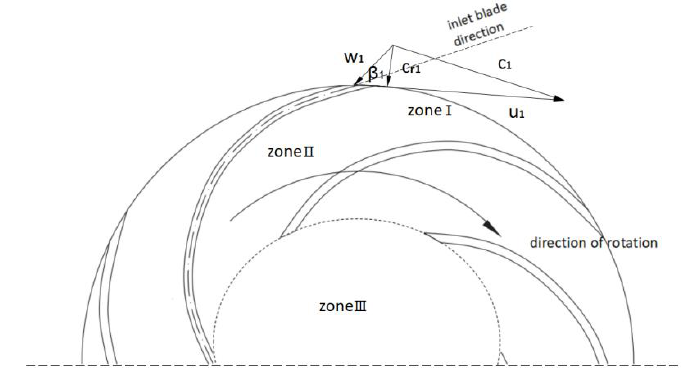
Figure 3. Velocity triangles in a radial flow PAT.